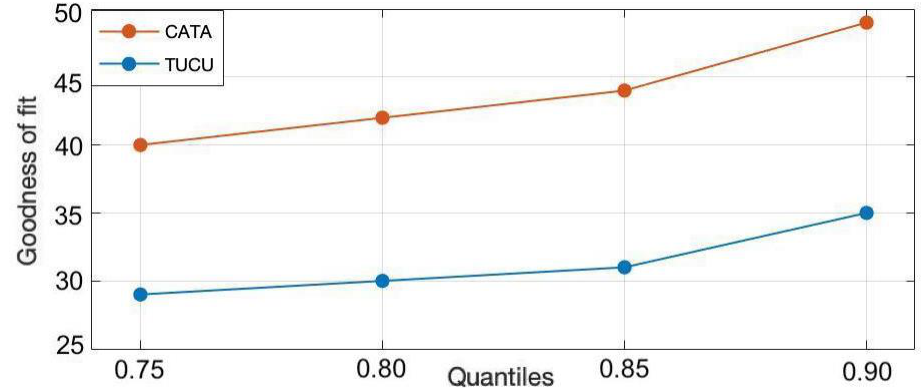
Figure 10. The goodness-of-fit criterion, Equations (7)–(10) for 0.75, 0.8, 0.85, and 0.9 quantiles and for TUCU and CATA stations. An improvement for higher quantiles is represented. The values are in